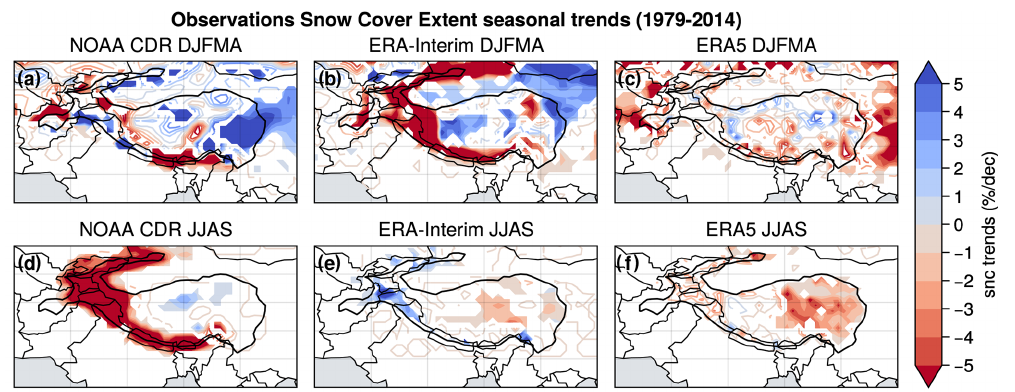
Figure D2. Same as Fig. 7 but for observations and reanalyses comparison with only snow cover extent.